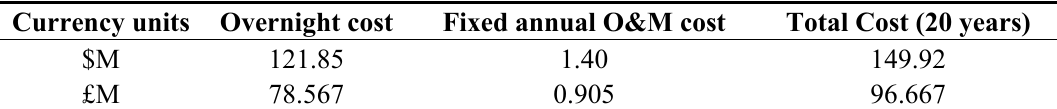
Table 7. Wind farm (50 MW)